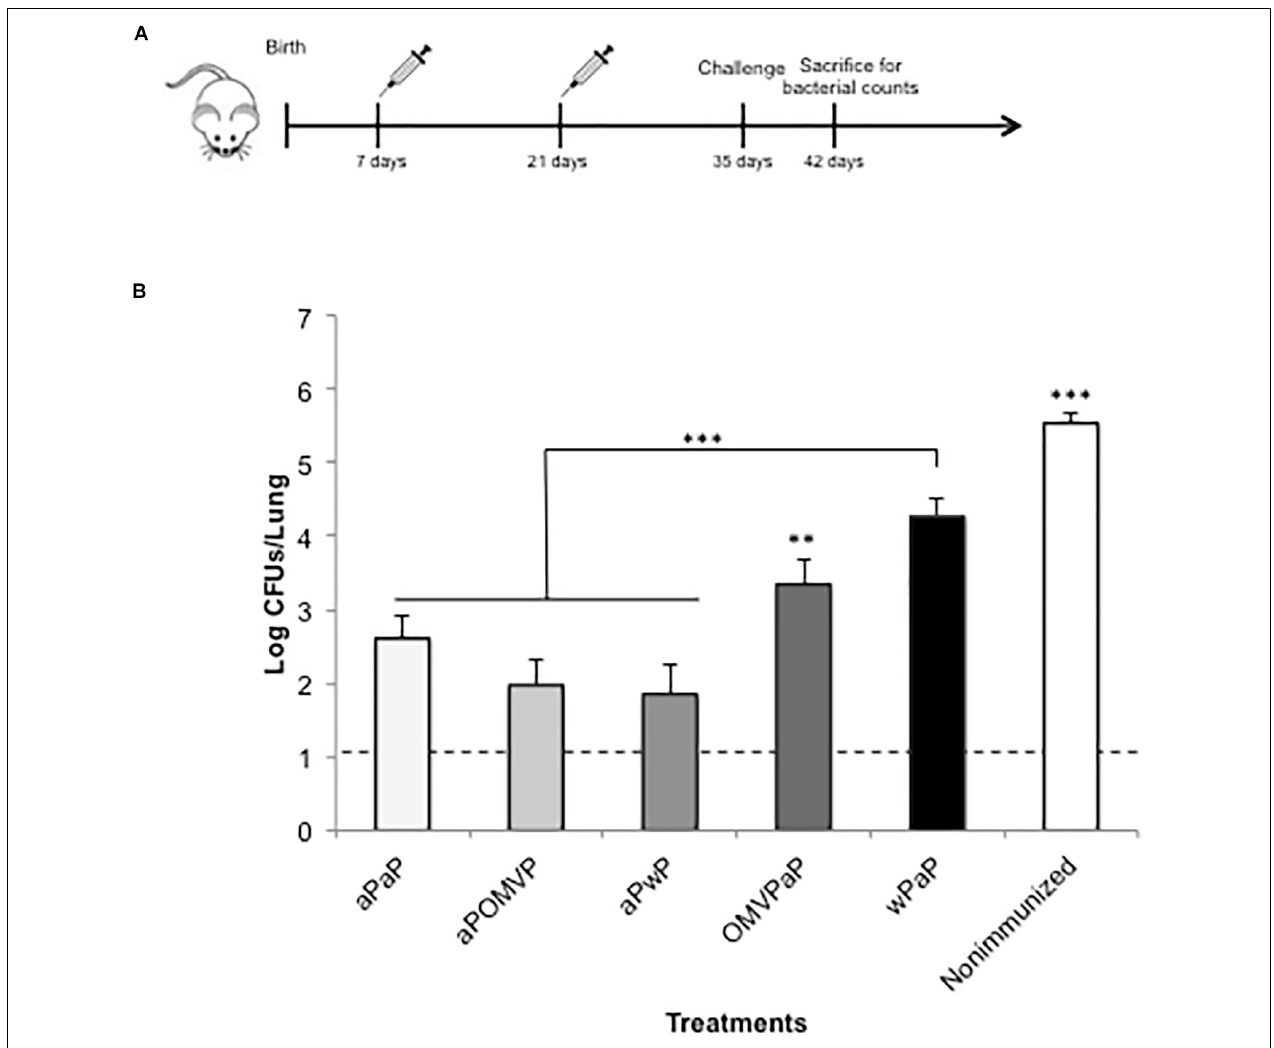
FIGURE 3 | Effect of 2-dose schedules including neonatal immunization on protection of offspring against B. pertussis infection. (A) Schematic representation of vaccination and challenge protocols. Seven-day-old neonatal mice were vaccinated with a commercial aP, OMV P, or a commercial wP vaccine ( n = 8 in each group). The second dose, involving a different type of vaccine from the first, was administered 14 days after the first dose. Non-immunized and aP-aP–immunized mice were used as respective negative and positive controls of protection. All the mice were then challenged with B. pertussis at 35 days after birth followed by sacrifice at 42 days. (B) Protection of offspring through the vaccination schedules of (A) . The number of bacteria recovered from mouse lungs, expressed as the log 10 of the CFUs per lung, is plotted on the ordinate for the combination of vaccine types indicated on the abscissa , with the data representing the means ± the SD. The dotted horizontal line demarcates the lower limit of detection. ∗∗∗ p < 0.001, ∗∗ p <